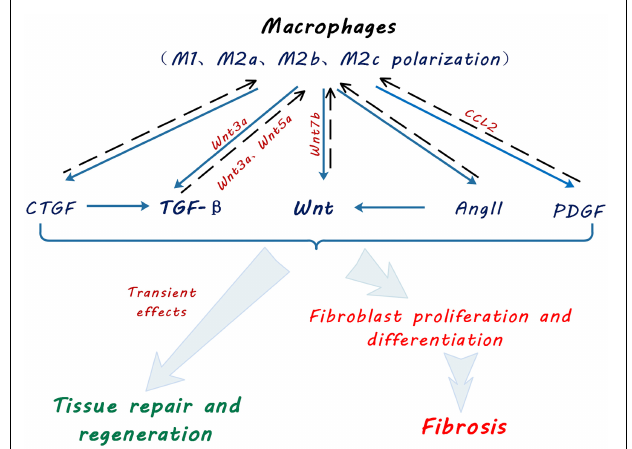
FIGURE 2 | Schematic diagram showing macrophage contribution to profibrotic signaling pathways. Macrophages promote tissue repair, regeneration and fibroblast activation and myofibroblast proliferation via multiple signaling pathways by secretion of transforming growth factor beta (TGF- β ), Wingless and Int-1 (Wnts), angiotensin II (Ang II), connective tissue growth factor (CTGF) and platelet-derived growth factor (PDGF). Solid arrows indicate secretion of cytokines and growth factors by macrophages. Broken line arrows indicate autocrine effects of macrophage-secreted cytokines and growth factors on macrophage functional polarization. Light blue arrows indicate effects of macrophage secreted cytokines and growth factors on kidney tissue repair and